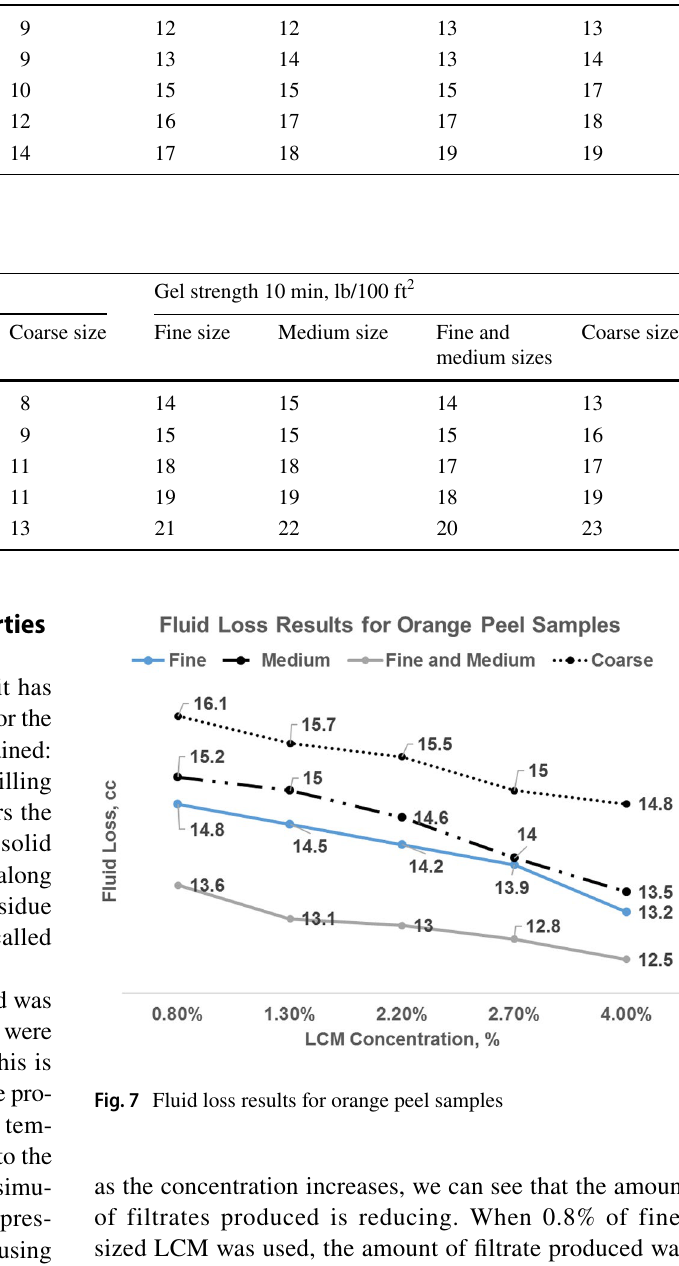
Table 3 Gel strength results for orange peel samples Concentra- tion (%)